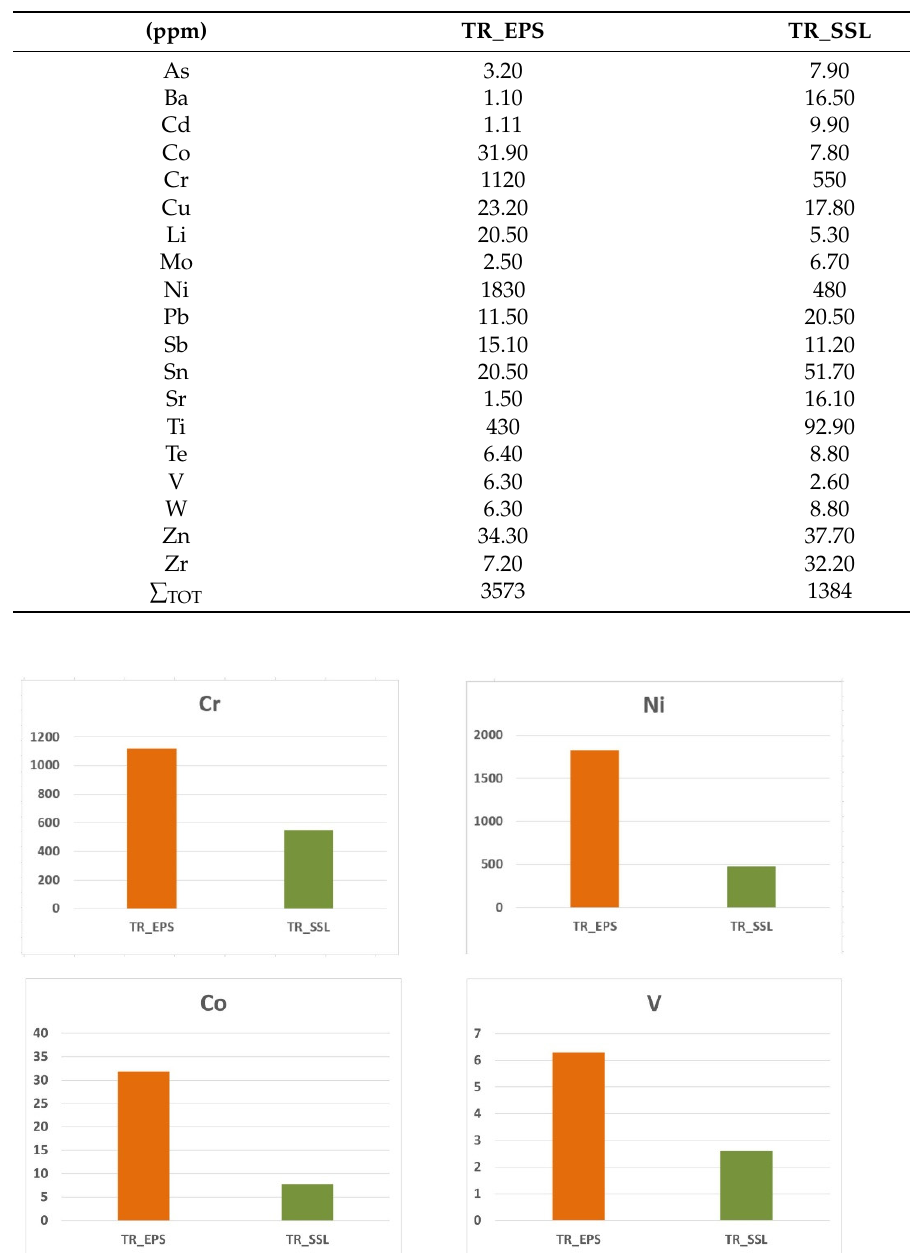
Figure 3. Bar diagrams showing the concentration of some PTEs (heavy metals expressed in ppm) in tremolite asbestos from Episcopia (TR_EPS) and San Severino Lucano (TR_SSL). More specifically, TR_EPS is the sample characterized by a higher concentration of Cr (1120 ppm) and Ni (1830 ppm) than TR_SSL, in which the concentrations are 550 ppm (Cr) and 480 ppm (Ni). Similarly, Co and V as well as Ti and Cu show the higher amounts in TR_EPS, while As and Zn are found in higher concentrations in the TR_SSL sample (Figure 3). In particular, the TR_EPS sample showed 31.9 ppm of Co, 6.3 ppm of V, high level of Ti (430 ppm) and 23.2 ppm of Cu, while TR_SSL reveals values of 7.8 ppm (Co), 2.6 ppm (V), 92.9 ppm (Ti) and 17.8 ppm of Cu. The other heavy metals considered, such as As and Zn, occur in high amounts in the TR_SSL sample: As is present at a concentration of 7.9 ppm in TR_SSL and 3.2 ppm in TR_EPS while Zn is 37.7 ppm and 34.3 ppm in TR_EPS and TR_SSL respectively. Figure 4 shows the concentration (ppm) levels